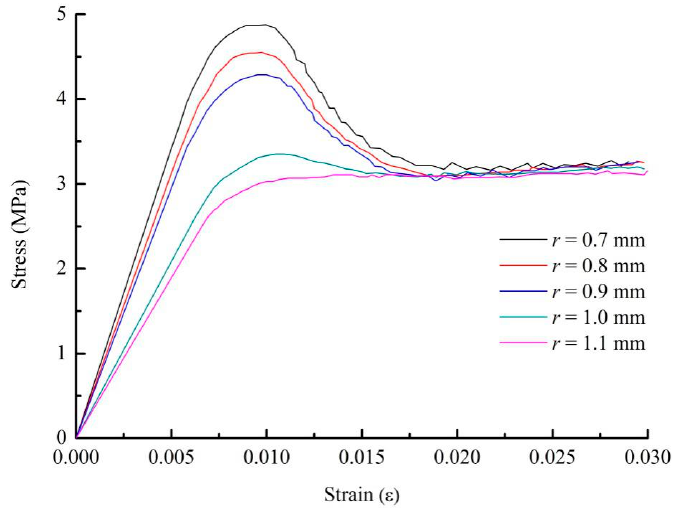
Figure 16. The calculation model for uniaxial compression of cylinder specimens.